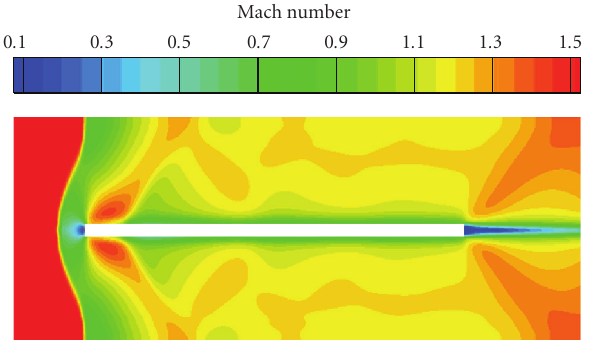
Figure 13: Mach No. distribution (HTPB slab @ AOA = 0 ◦ ).